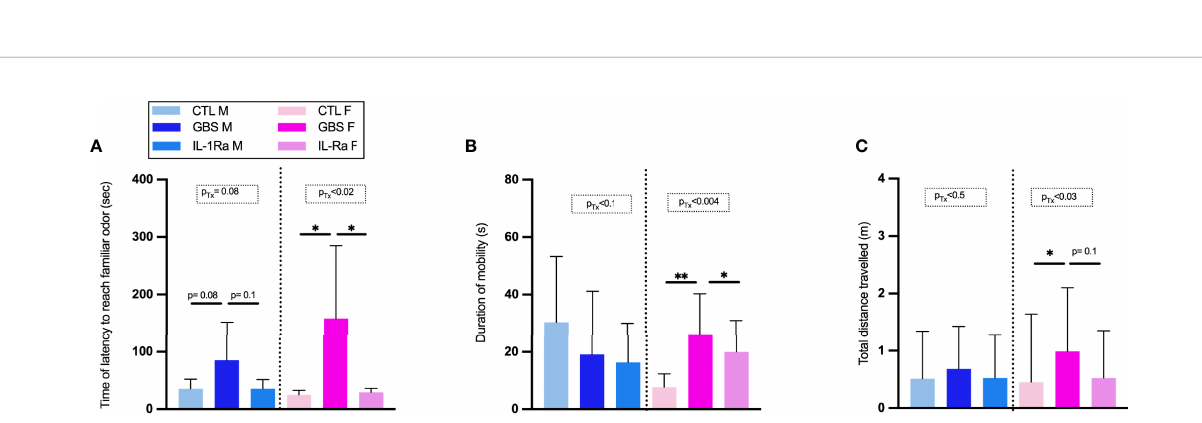
FIGURE 7 | Effect of IL-1Ra on reducing neurobehavioral impairments in male and female offspring. Time of latency to reach familiar odor (A) , Duration of mobility (B) , Total distance travelled (C) . Data were collected from three individual experiments. Statistical analyses were done by one-way ANOVA or Kruskal-Wallis test with Dunnett ’ s or Dunn ’ s multiple comparisons multiple between the experimental groups (CTL, GBS, and GBS plus IL-1Ra); *p < 0.05, **p < 01. Bars show mean ± SEM. Number (n) of male and female: CTL (male and female, n = 6-11), GBS (male and female, n = 7- 10), and GBS plus IL-1Ra, (male and female, n = 4-8). Bars show mean ± SEM. F, female; GBS, group B Streptococcus; IL, interleukin; IL-1Ra, IL-1 receptor antagonist; M, male; n, number; SEM, standard error of the mean; Tx,